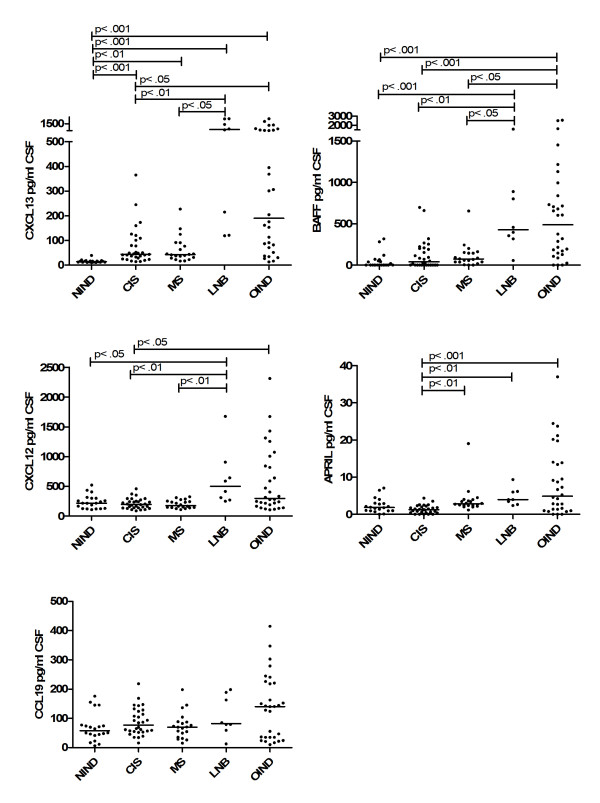
 Chemokine/Cytokine levels in CSF. CXCL13, CXCL12, CCL19, BAFF and APRIL CSF levels of patients with non-inflammatory neurological diseases (NIND), clinically isolated syndrome (CIS), multiple sclerosis (MS), Lyme neuroborreliosis (LNB) and patients with other inflammatory neurological diseases (OIND) are shown. CCL21 was not detectable in the CSF. Horizontal line indicates median, significant P-values for the comparison among groups are displayed.